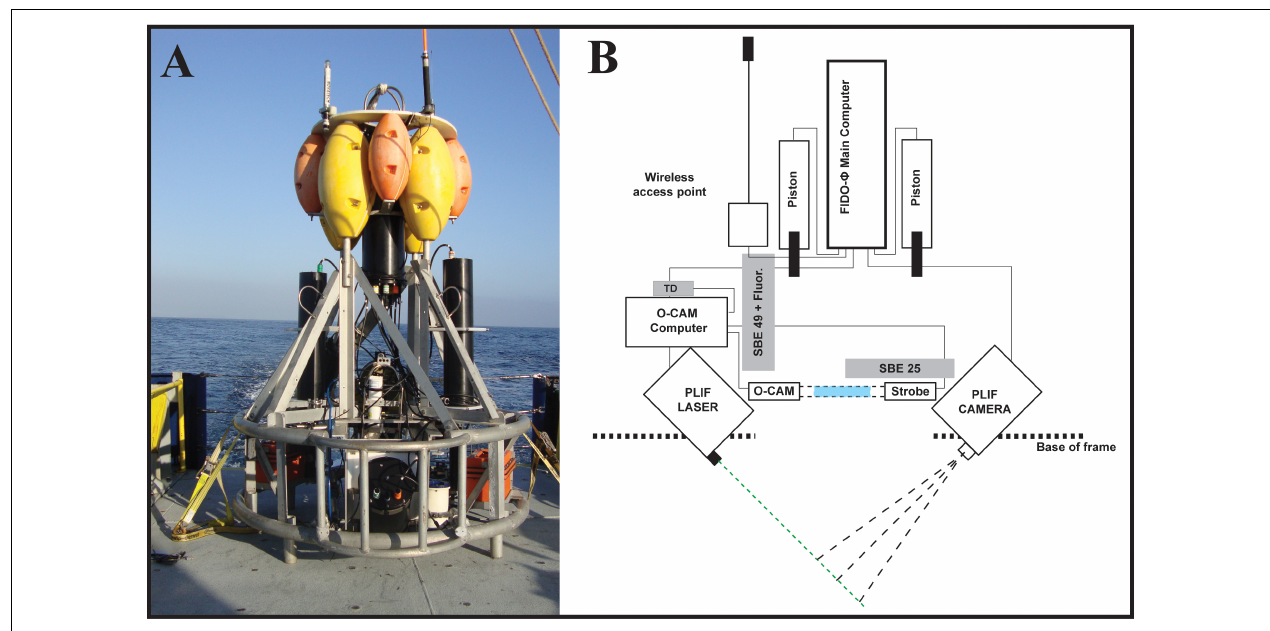
FIGURE 1 | (A) FIDO- (cid:56) /O-Cam on the deck of R/V New Horizon during the August 2011 cruise. (B) Modified schematic from Prairie et al. (2011) to reflect the sensors used for this work. Notice the relative position of the imaging volumes for the PLIF (Intersection of camera and laser dashed lines) and O-Cam (blue rectangle) systems, as well as the location of the imaging volumes with respect to CTD (SBE 25 and SBE 49) and Temperature Depth (TD)